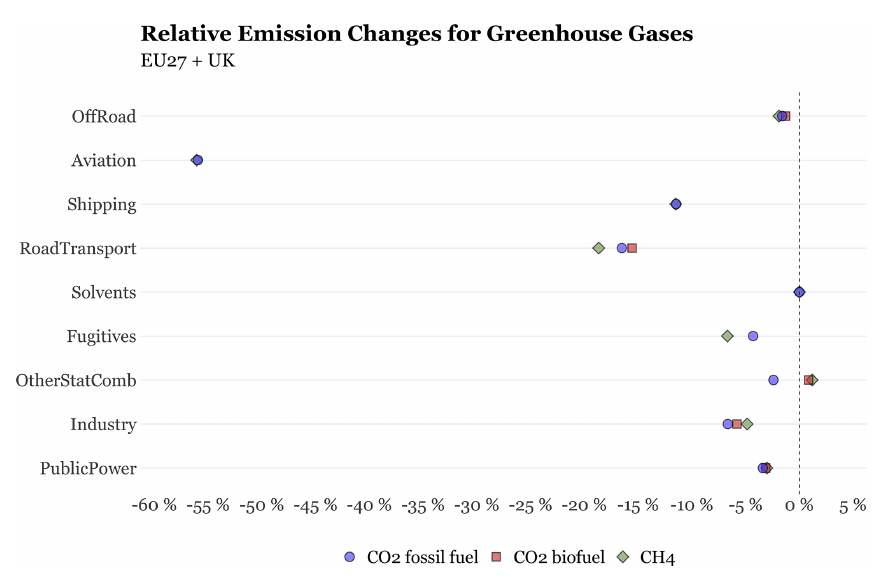
Figure 9. Same as Fig. 8 for greenhouse gases. Note that for aviation, shipping, use of solvents and fugitives, no emissions are reported for CO 2